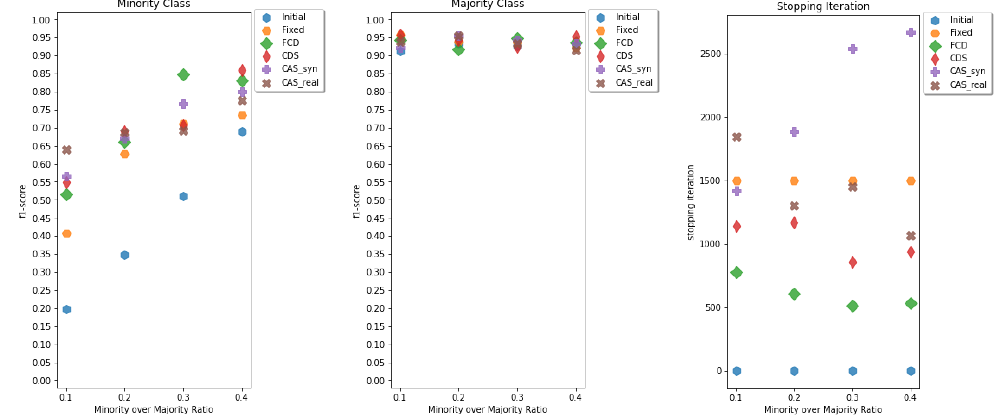
Figure 16. Average F1 results of cira-based datasets by imbalance ratio for minority ( left ) and majority ( center ) classes, and average number of iterations until the training is stopped ( right ).